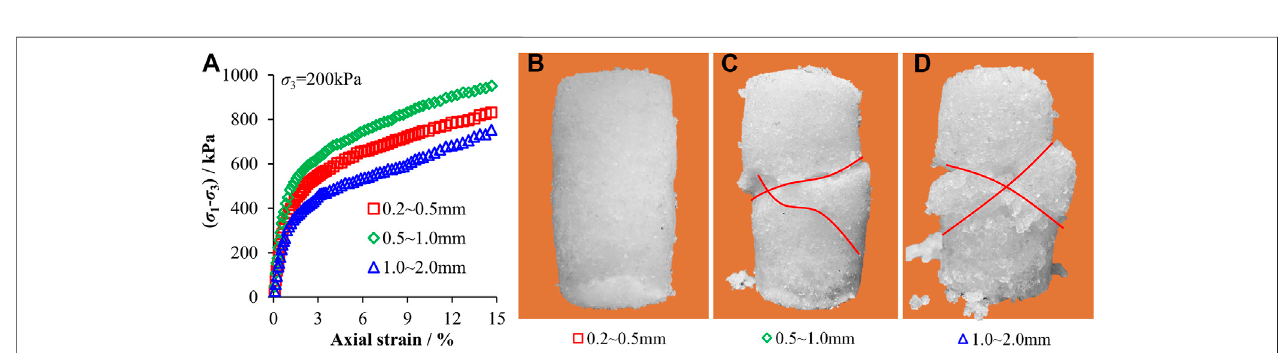
FIGURE 14 | Stress – strain responses (A) and failure modes of the specimens with different particle sizes (separately 0.2 – 0.5 mm (B) , 0.5 – 1.0 mm (C) and 1.0 – 2.0 mm (D) ) of fused quartz.